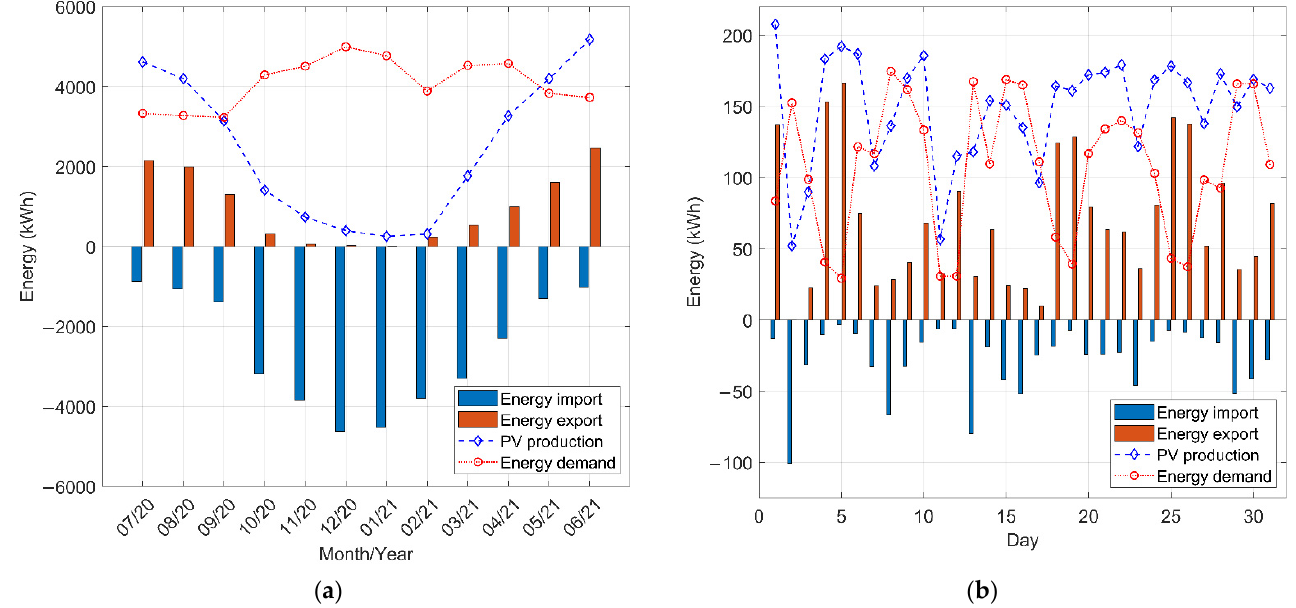
Figure 8. ( a ) Monthly profile of energy balance of the PV9 system and ( b ) daily energy profiles of the PV9 system collected in July 2020 (summer